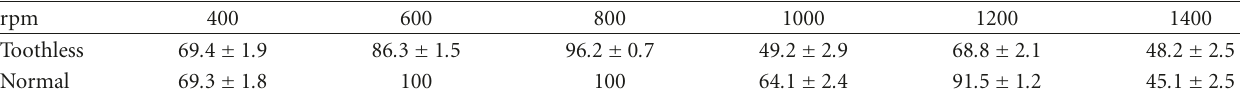
Table 3: Average percentage of correctly classified testing signals coming from toothless and normal gears working in the absence of load. rpm 400 600 Toothless